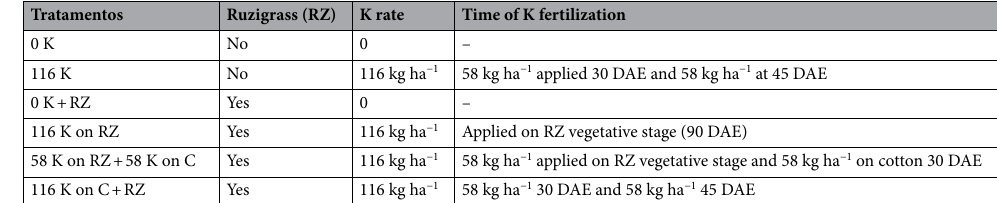
a.i.), and cotton was planted on December 9, 2016, and November 23, 2017. Phosphorus was applied at 56 kg ha −1 and N at 30 kg ha −1 as mono ammonium phosphate at cotton planting. The rate of 140 kg ha −1 of N was sid- edressed and split 35 and 45 days after plant emergence (DAE), using ammonium sulphate and urea, respectively. Boric acid was sprayed at 2.0 kg ha −1 split into 4 weekly applications from the first flower. Weed, pests, and dis- eases were controlled according to standard farm practices in São Paulo State. Seven days before harvest plants were defoliated with Tidiazurom (60 g ha −1 a.i.) + Diuron (30 g ha −1 a.i). Cotton was handpicked 141 and 132 DAE in 2016/17 and 2017/18, respectively. At full flowering, the fourth/fifth leaf from the top was sampled from 10 plants per plot for foliar diagnosis 30 . The tissue was dried to constant weight in a forced air oven at 65 ºC, ground and K was determined using atomic absorption. At harvest, plant height and the number of nodes per plant were determined in 5 randomly assigned plants per plot. Cotton yield, boll number and weight were determined by counting and weighing all bolls from the central 2.0 m of the inner cotton rows. A subsample was taken to be ginned, and the gin turnout, fiber strength, length, maturity, micronaire and short fiber index were determined using a High Volume Instrument 31 . After harvest, soil was sampled at 0–20 cm depth for exchangeable K analysis as in Raij et al. 29 . Potassium use efficiency (KUE) was calculated using Eq. (1) for treatments without ruzigrass and Eq. (2) for treatments with ruzigrass: